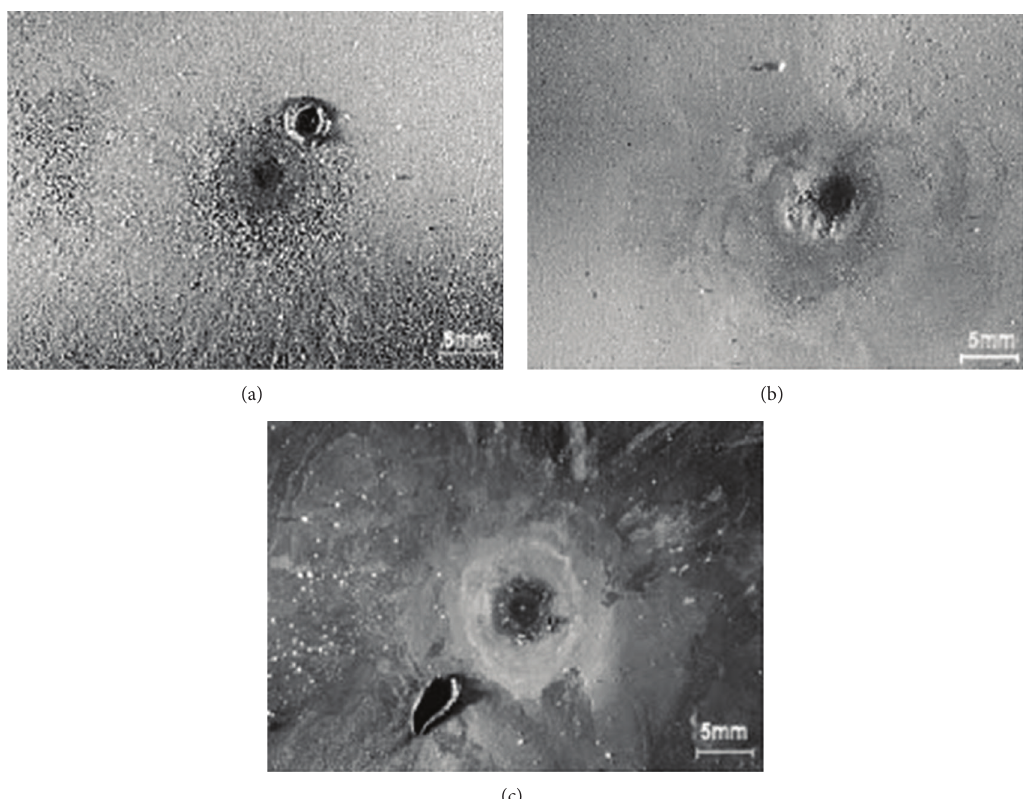
Figure 5: Images of the eroded surface of the specimens: (a) LDPE; (b) LDPE + MMT 5%; (c) LDPE + Si 5%